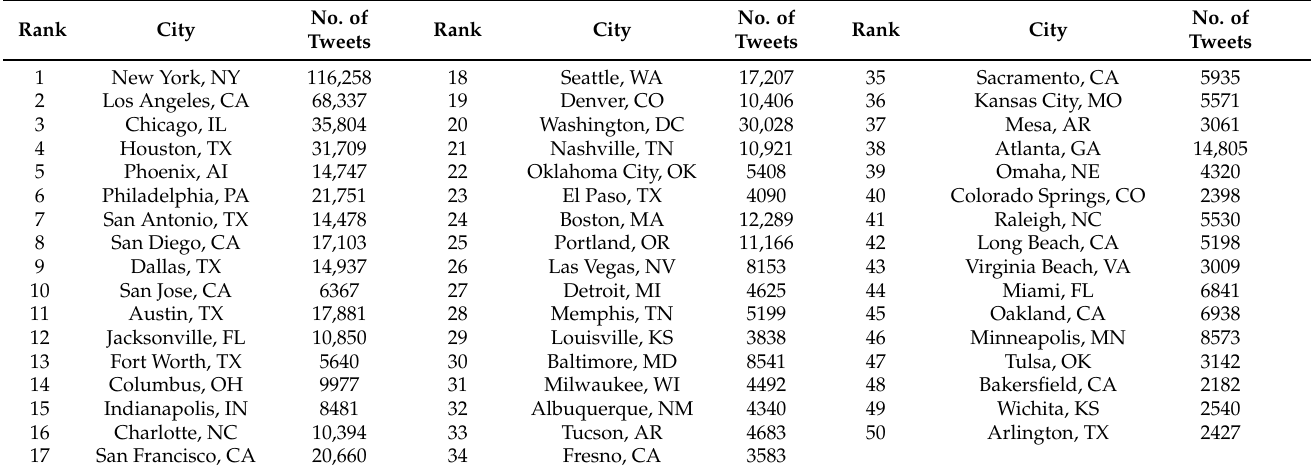
Table 8. Top 50 cities with most